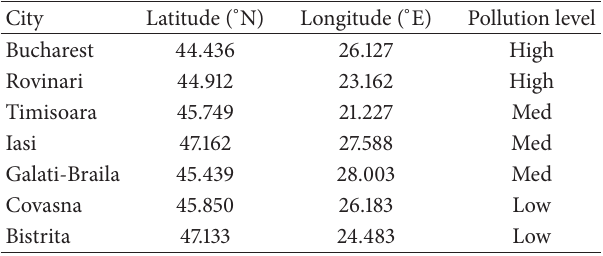
Table 2: Coordinates and pollution level for selected cities.